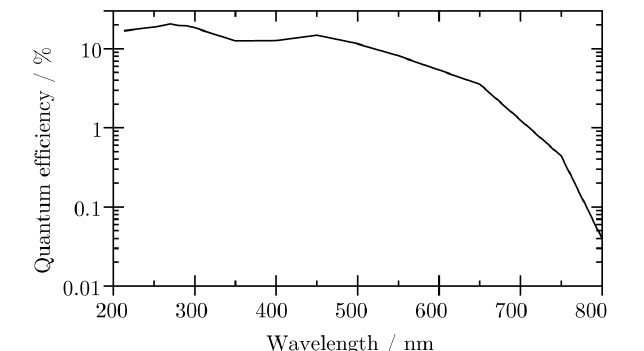
Figure 5. Exemplary detector efficiency as function of photon wavelength of a Photek MCP240 detector with a fused silica window and bialkali photocathode